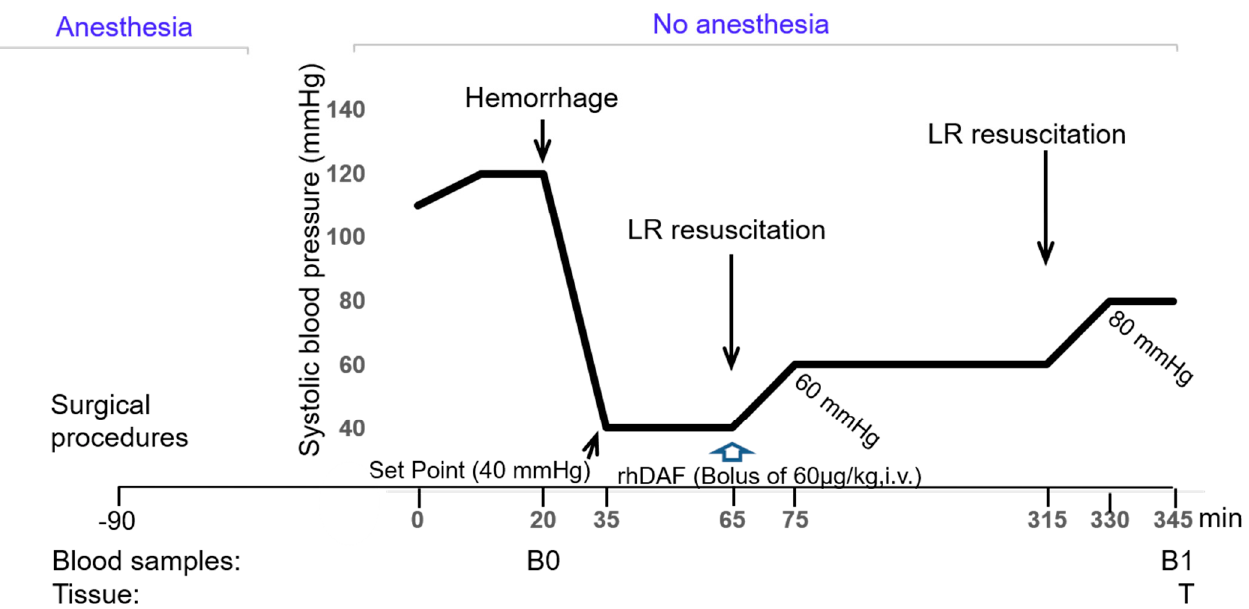
Figure 9. Scheme of the experimental design. Target mean arterial blood pressure (MAP), the blood, and tissue sample collection are shown. There was additional bleeding for maintaining the target pressure after the hemorrhage phase, but there was no shed blood infusion.